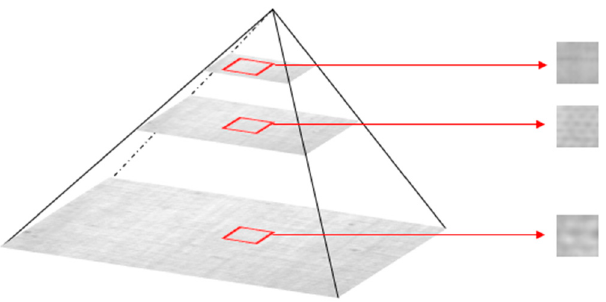
Figure 3. Gaussian pyramid to extract fixed-size image patches from different scale level.